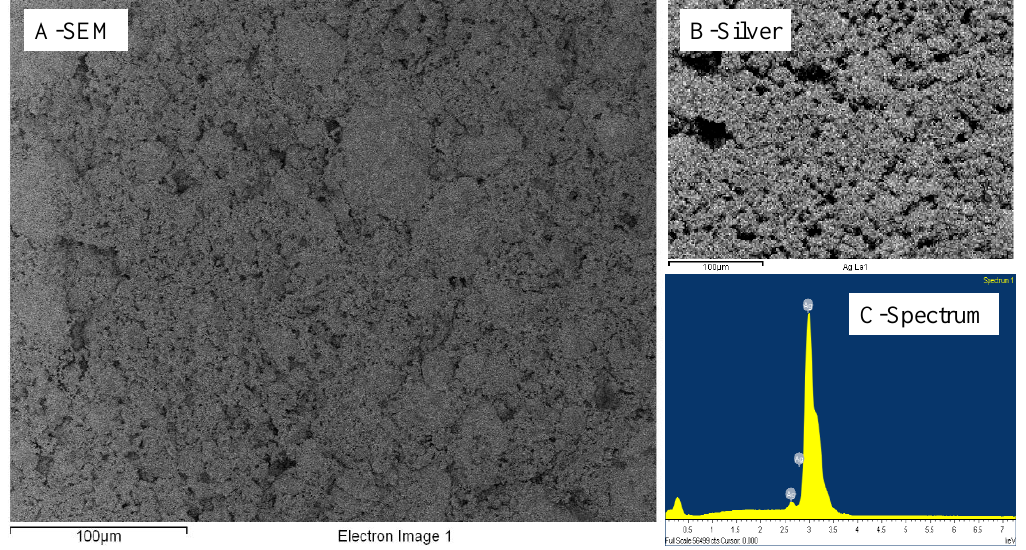
Figure 6. Representative EDS distributions of Si, Ag and O elements across a 10 wt% silica content cold-pressed composite after silica etching–a small amount of carbon can be detected residual from sample preparation for SEM imaging; no Si and minutes amount of O could be detected; the scale bar corresponds to 100